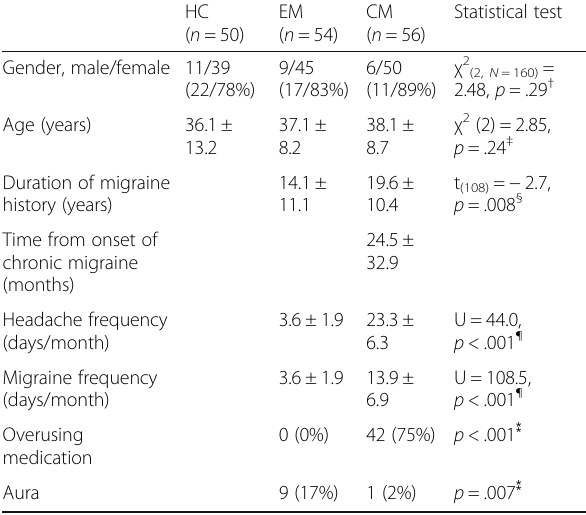
Table 1 Clinical and demographic characteristics of